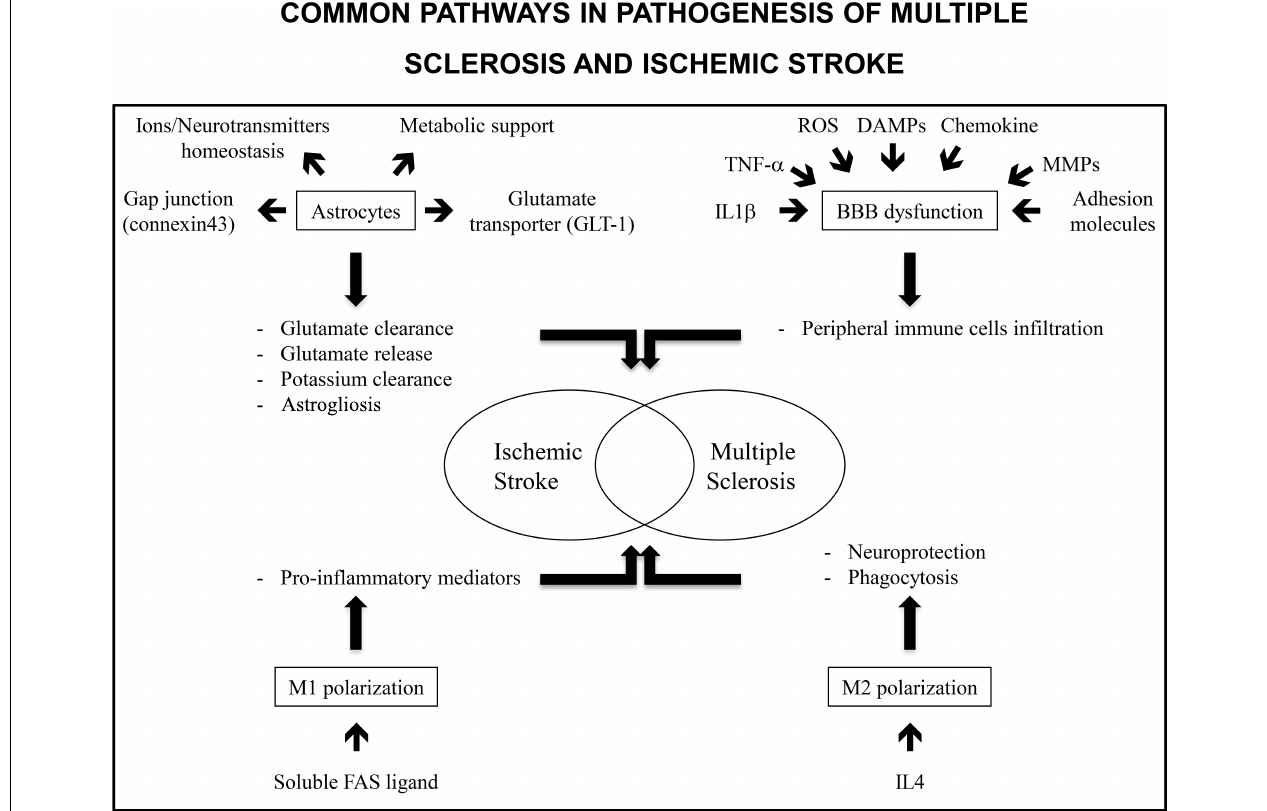
FIGURE 1 | Common pathways in pathogenesis of multiple sclerosis and ischemic stroke include astrocytes, BBB dysfunction and M1/M2 polarization. Astrocytes are involved in ions and neurotransmitters homeostasis and metabolic support. Gap junctions as well as glutamate transporters allow for glutamate uptake and clearance. Similarly, gap junctions allow for potassium clearance. Stored glutamate may be released by astrocytes and may be responsible for delayed lesions. In the same way astrogliosis has deleterious and protective effects. It protects preserved tissue from inflammation but decreased neurogenesis in ischemic tissue. Inflammatory markers such as TNF- α or IL1- β , reactive oxygen species, danger associated molecular patterns (DAMPs, molecules released from necrotic cells), chemokines, matrix metalloproteinases (MMPs), and adhesion molecules expression contribute to BBB disruption and peripheral immune cells infiltration. M1 polarization of immune cells is associated with an increase in pro-inflammatory mediators and deleterious effects on neuronal lesions. In contrast, M2 polarization is associated with neuroprotection and dead cells phagocytosis allowing for a decrease in inflammation.